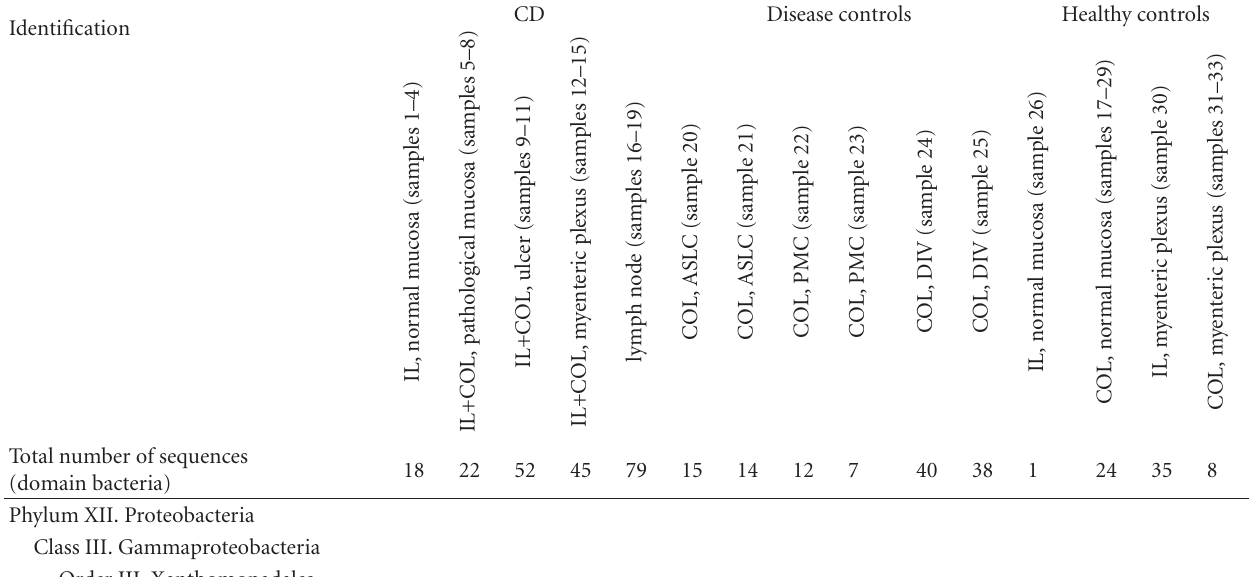
Table 5: Distribution of bacterial taxa over the 33 tissue samples ( ∗ ) ( ∗∗